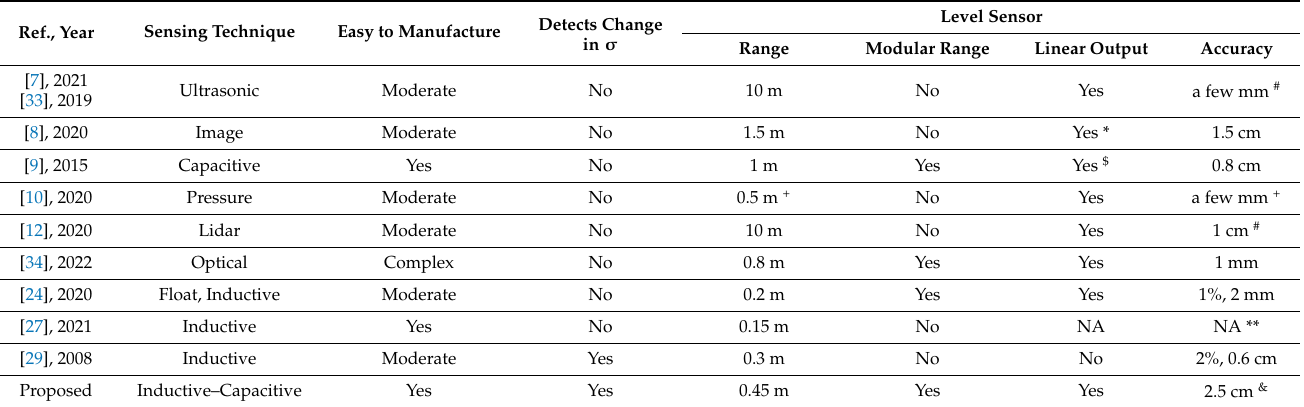
Table 1. Comparison with the important level-sensing